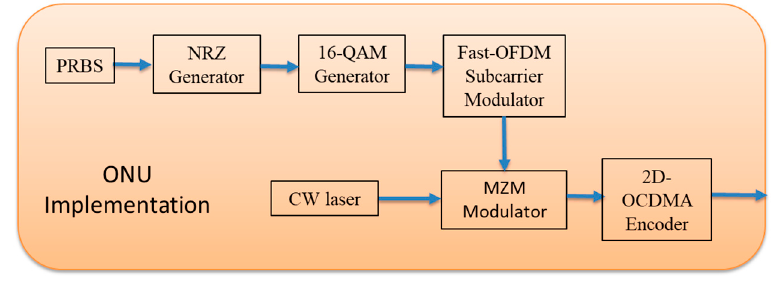
Figure 6. ONU implementation.